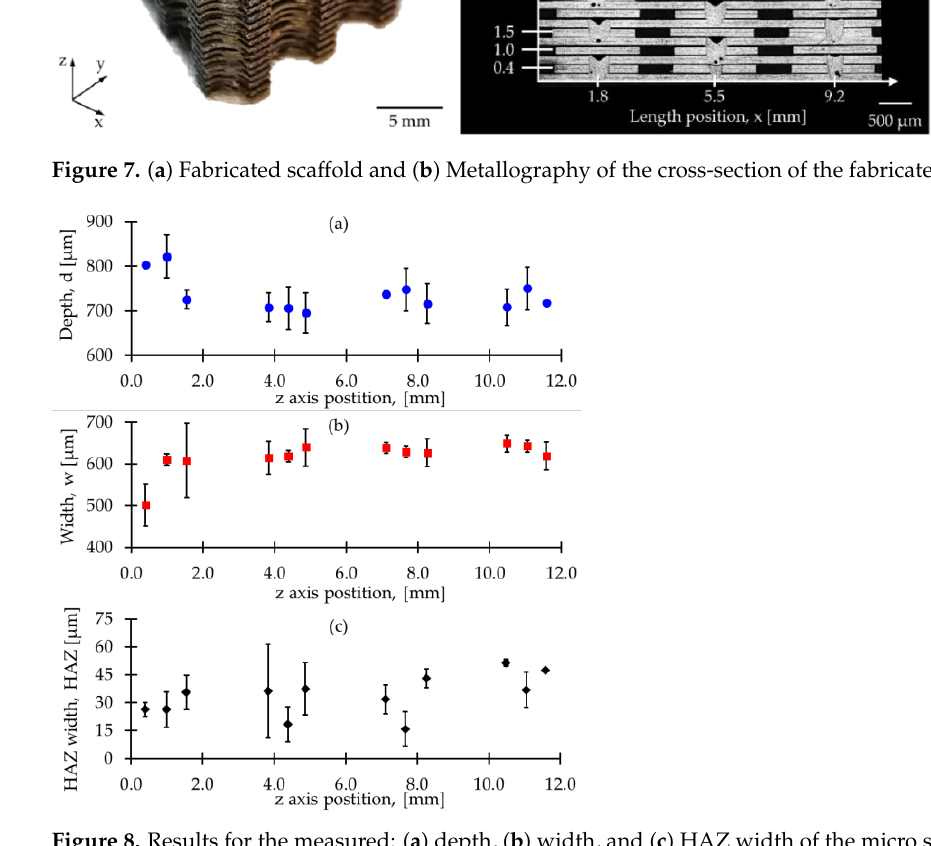
Figure 8. Results for the measured: ( a ) depth, ( b ) width, and ( c ) HAZ width of the micro spot welds.